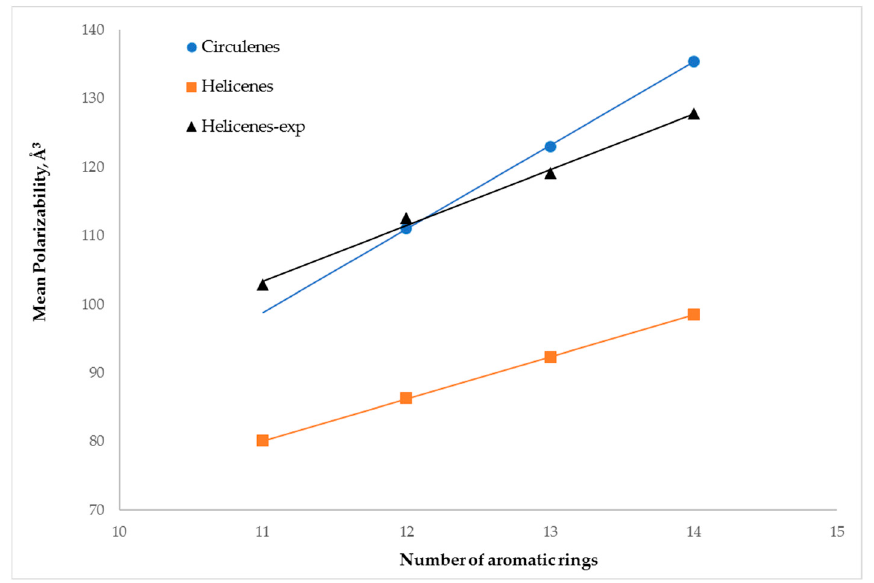
Figure 2. The relationship between the mean polarizability and the number of aromatic rings for selected PAHs.